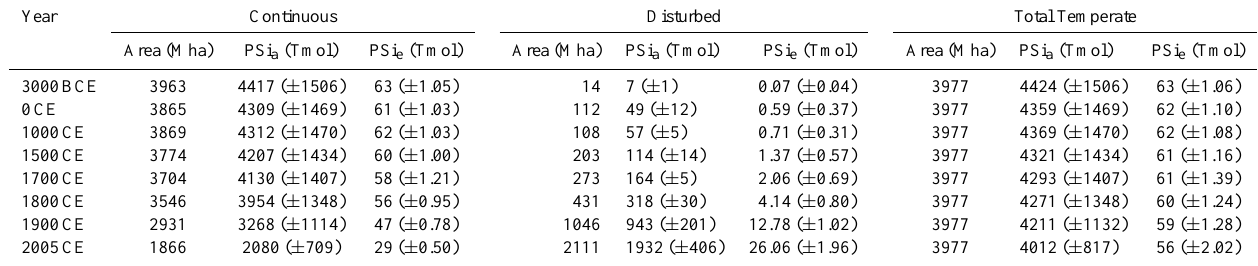
Table 2. Historical evolution (3000BCE–2005CE) of the biogenic silica (PSi a ) and easily soluble silica pools (PSi e ) for continuous, disturbed and total land area in temperate soils. Standard errors are given in between parentheses. Land use data: Klein Goldewijk et al. (2011) and World Bank databank http://data.worldbank.org/, last acces: 22 February